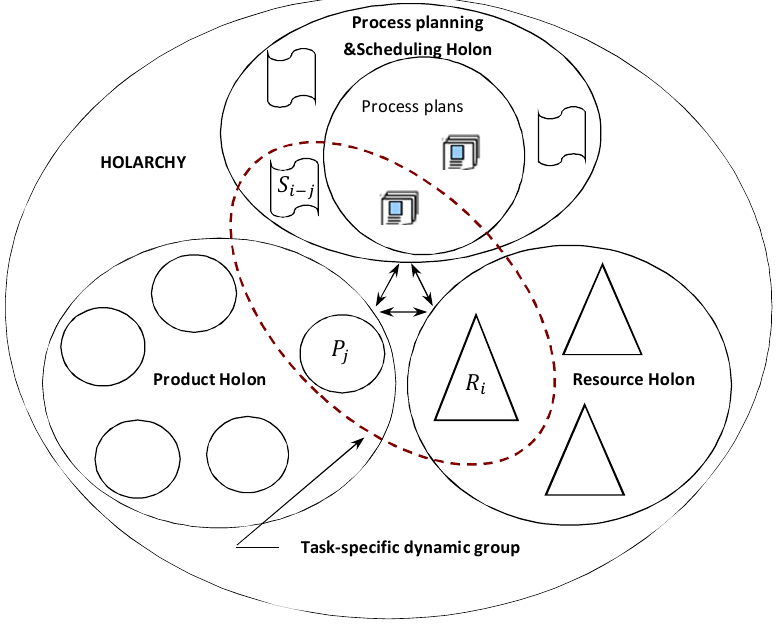
Fig. 1. Proposed Holonic manufacturing